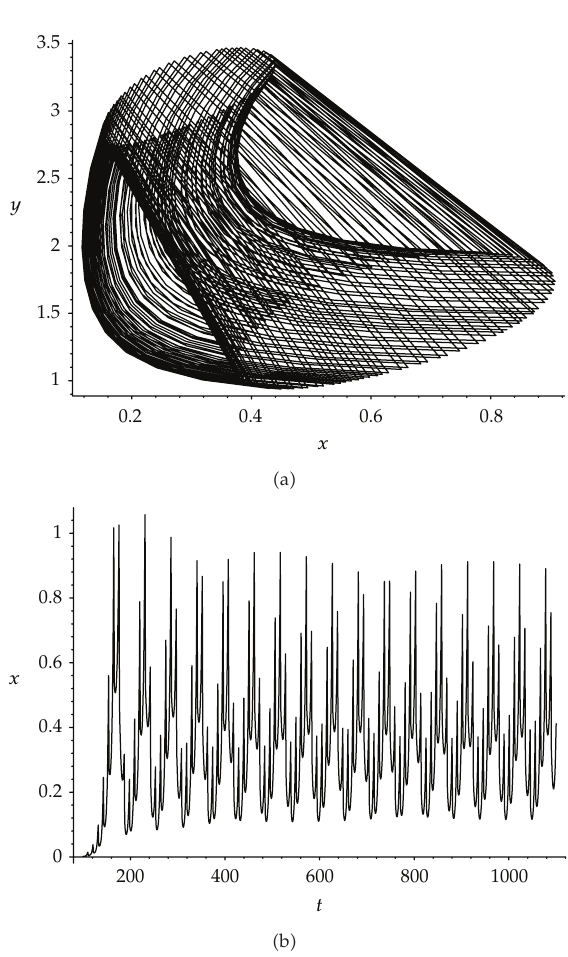
Figure 4: Strange attractor. (cid:2) a (cid:3) Chaotic attractor when T (cid:7) 11, (cid:2) b (cid:3) time series of algae population when T (cid:7)